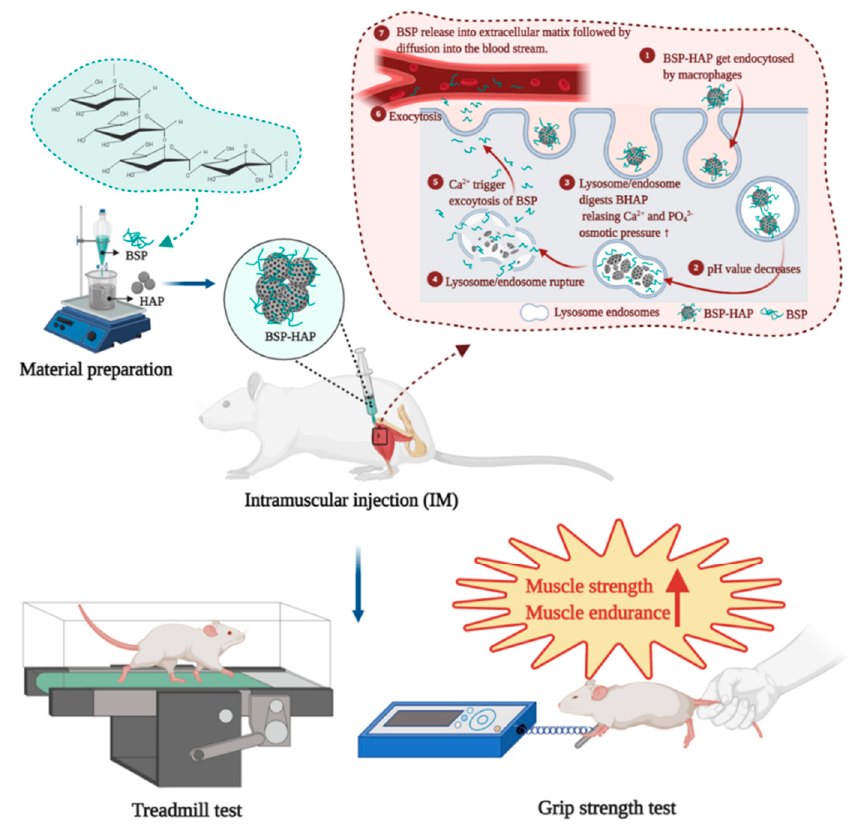
Figure 1. The developed Bletilla striata and hydroxyapatite (BSP-HAP) particle preparation and in vivo delivery via intramuscular (IM) injection. Shown are the sequences of BSP-HAP particle synthesis. In addition, the method of IM injection of BSP-HAP particles is indicated and so are the multiple steps and mechanisms involved for the BSP delivery to the blood circulation system.